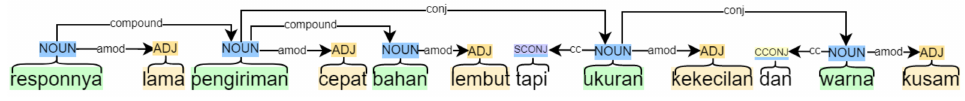
Figure 2. An example of using dependency parse.